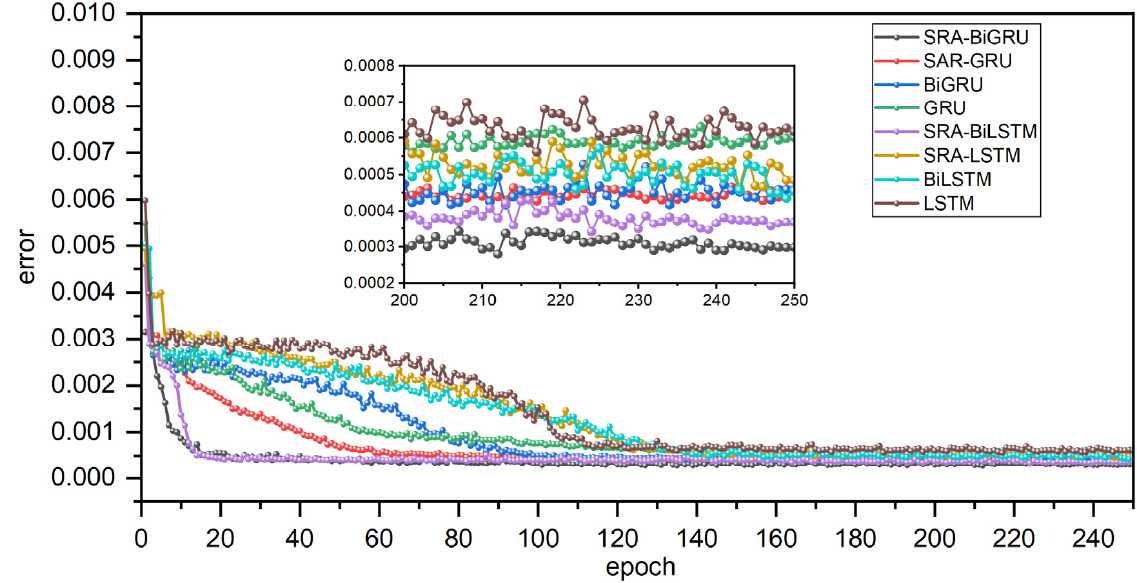
Figure 10. Loss value of all comparative experiments.